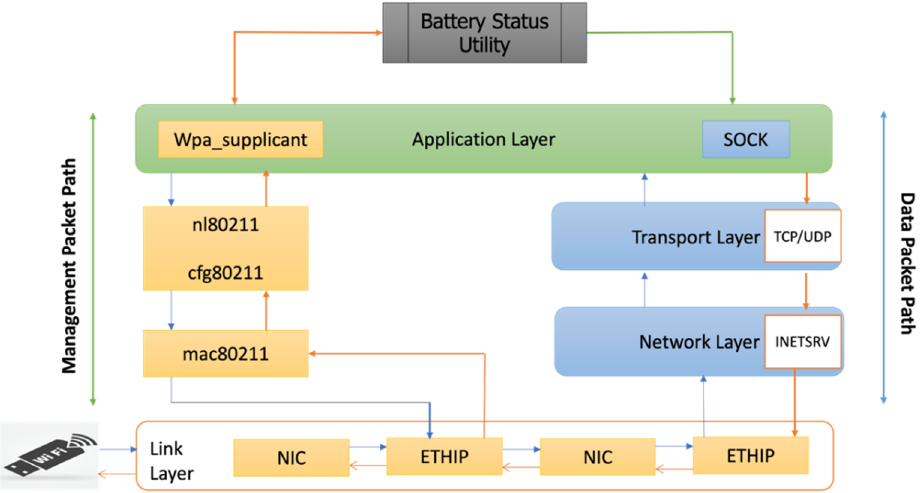
Figure 7. Proposed Station Framework.